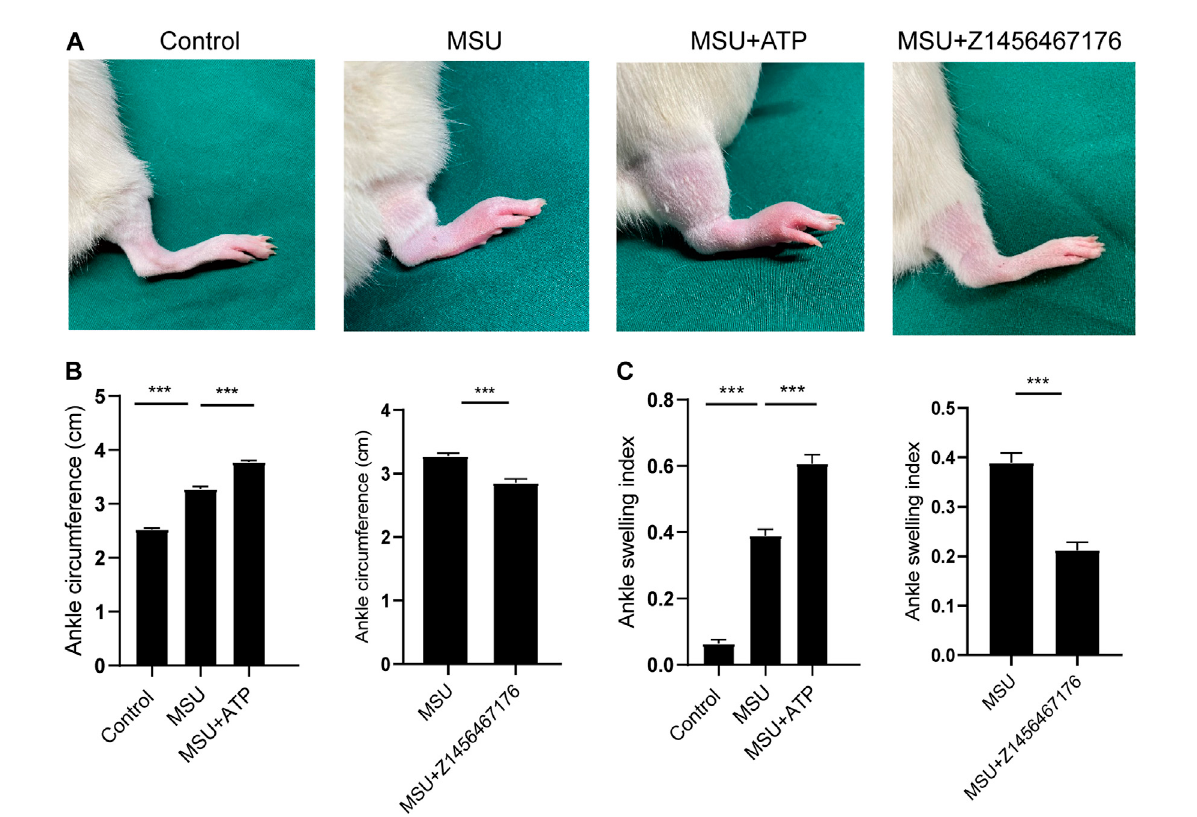
FIGURE. 5 Z1456467176 alleviates gouty arthritis in rats. The rat model of gout was divided into four groups: the control group, MSU group, MSU + ATP group, and MSU + Z1456467176 group. (A) Representative diagram of the right ankle joint of rats. (B,C) Ankle joint circumference and joint swelling indexofthefourgroupsofrats.Dataarepresentedasthemeans±S.E.M.s.Statisticswereanalyzedusingtheindependentsamples t testorDunnett ’ s t test. n = 4. *** p <